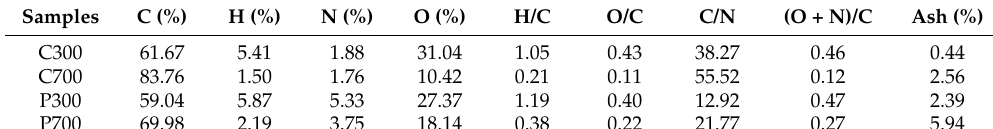
Table 2. Elemental composition (on a dry mass basis) and atomic ratios of biochars.